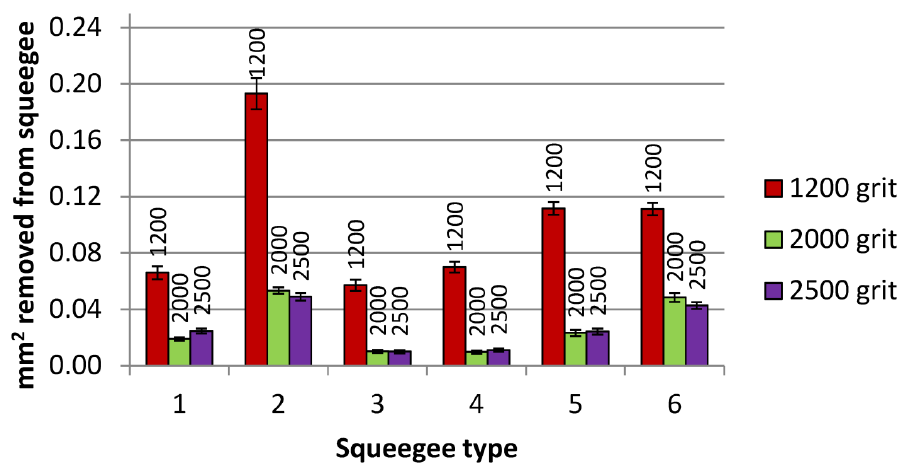
Figure 10. Squeegee cross-sectional area removed after 50 wear cycles with different silicon carbide abrasives. Error bars show standard